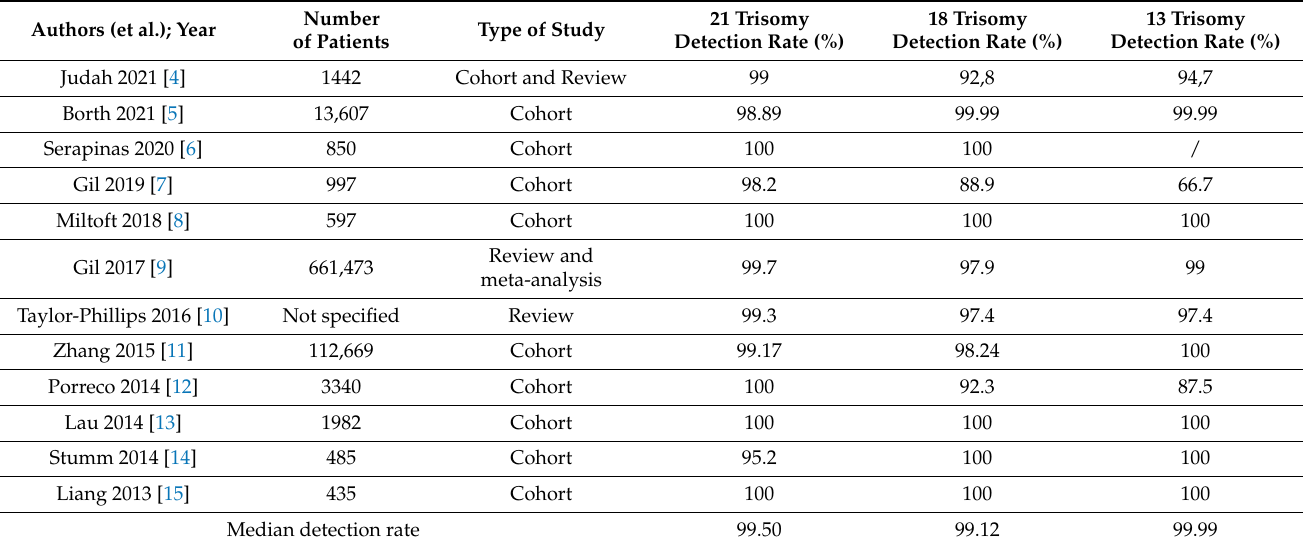
Table 1. Non-invasive prenatal diagnosis of chromosomal aneuploidies studies included in the re- view.